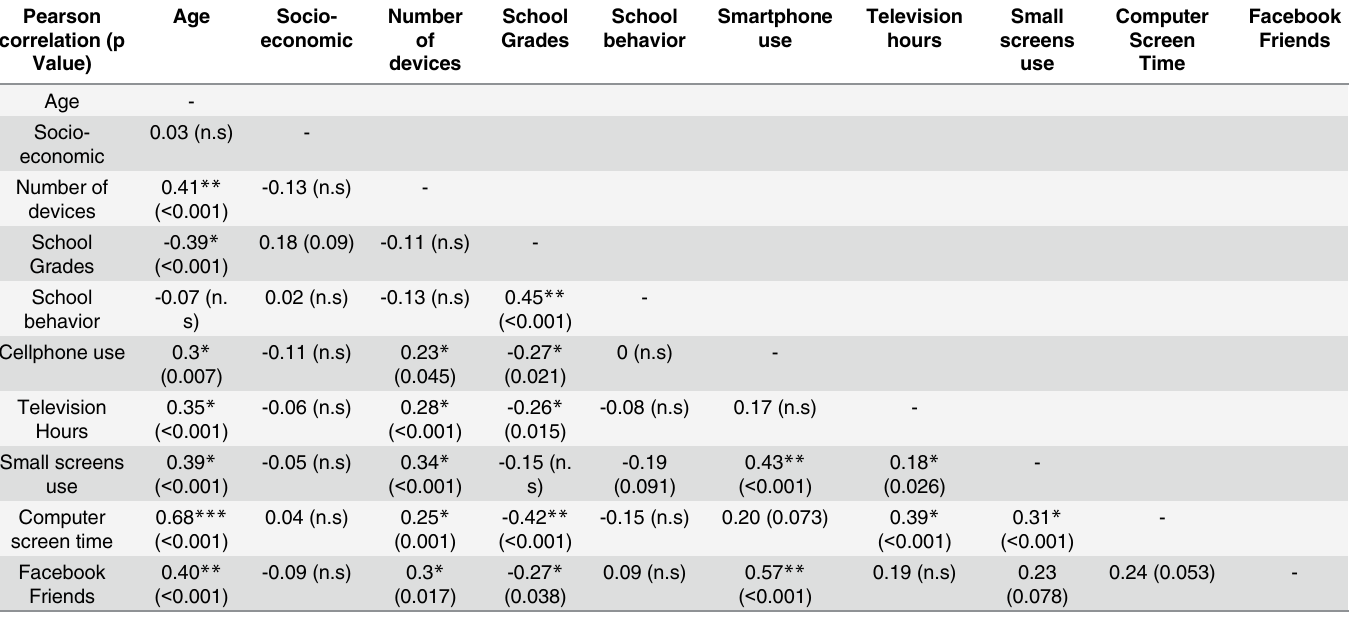
Table 3. Correlations between variables entering the logistic regression